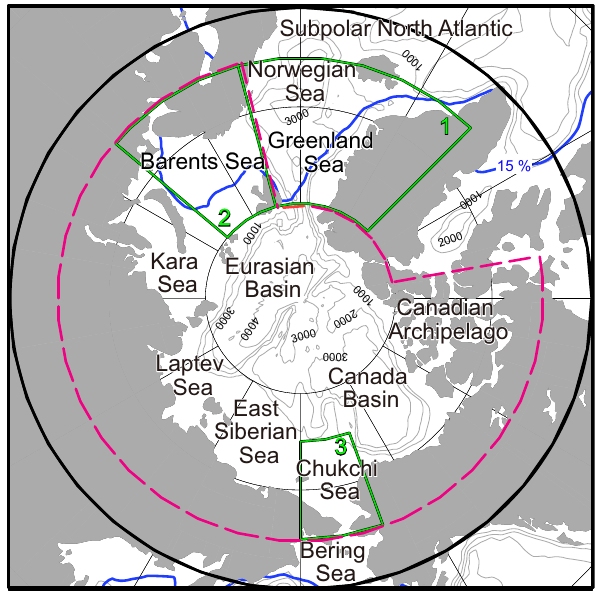
Figure 1. Map of the Arctic Ocean and its adjacent seas. Gray contour lines show the 1000, 2000, 3000, and 4000m isobaths. Blue lines show the 17-year annual mean position of the ice edge (SIC = 15%). Area for the mapping is north of 60 ◦ N (heavy black circle). Sectors selected for regional analysis are the Arctic Ocean (dashed magenta line), the Greenland and Norwegian seas (green 1), the Barents Sea (green 2), and the Chukchi Sea (green 3).